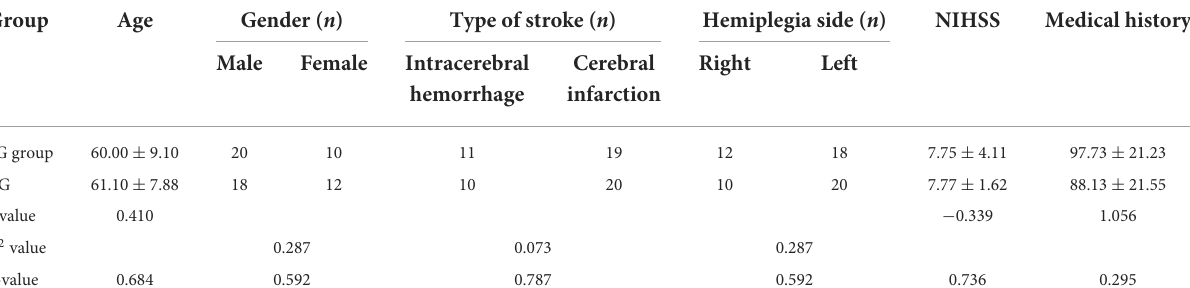
TABLE 1 Baseline characteristics of the patients in two groups. Group Age Gender ( n ) Type of stroke ( n ) Hemiplegia side ( n ) NIHSS Male Female Intracerebral Cerebral Right Left hemorrhage